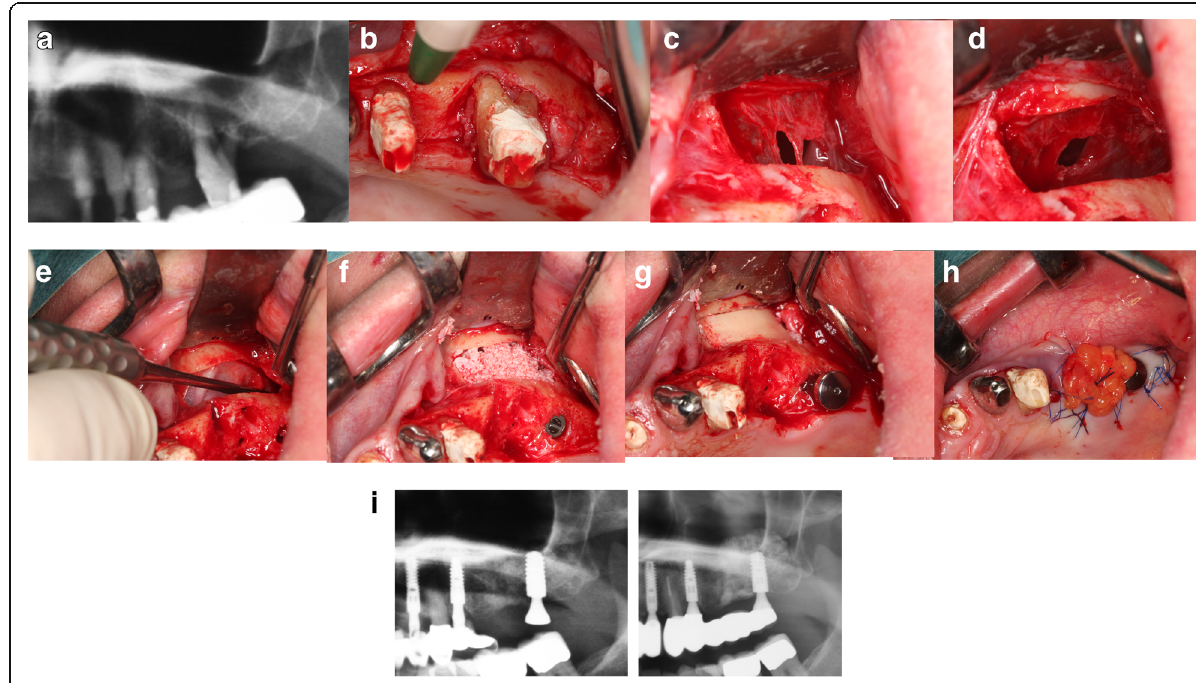
Fig. 7 a Pre-operative X-ray. b Tooth 26. c Perforation of the Schneiderian membrane. d Perforation after elevating the Schneiderian membrane. e Covering the perforation with a collagen membrane and fibrin glue. f Augmentation and implant inserted. g Repositioning of the buccal bone. h Covering of the OAC with the BFP. i Post-operative X-ray vs 3 years